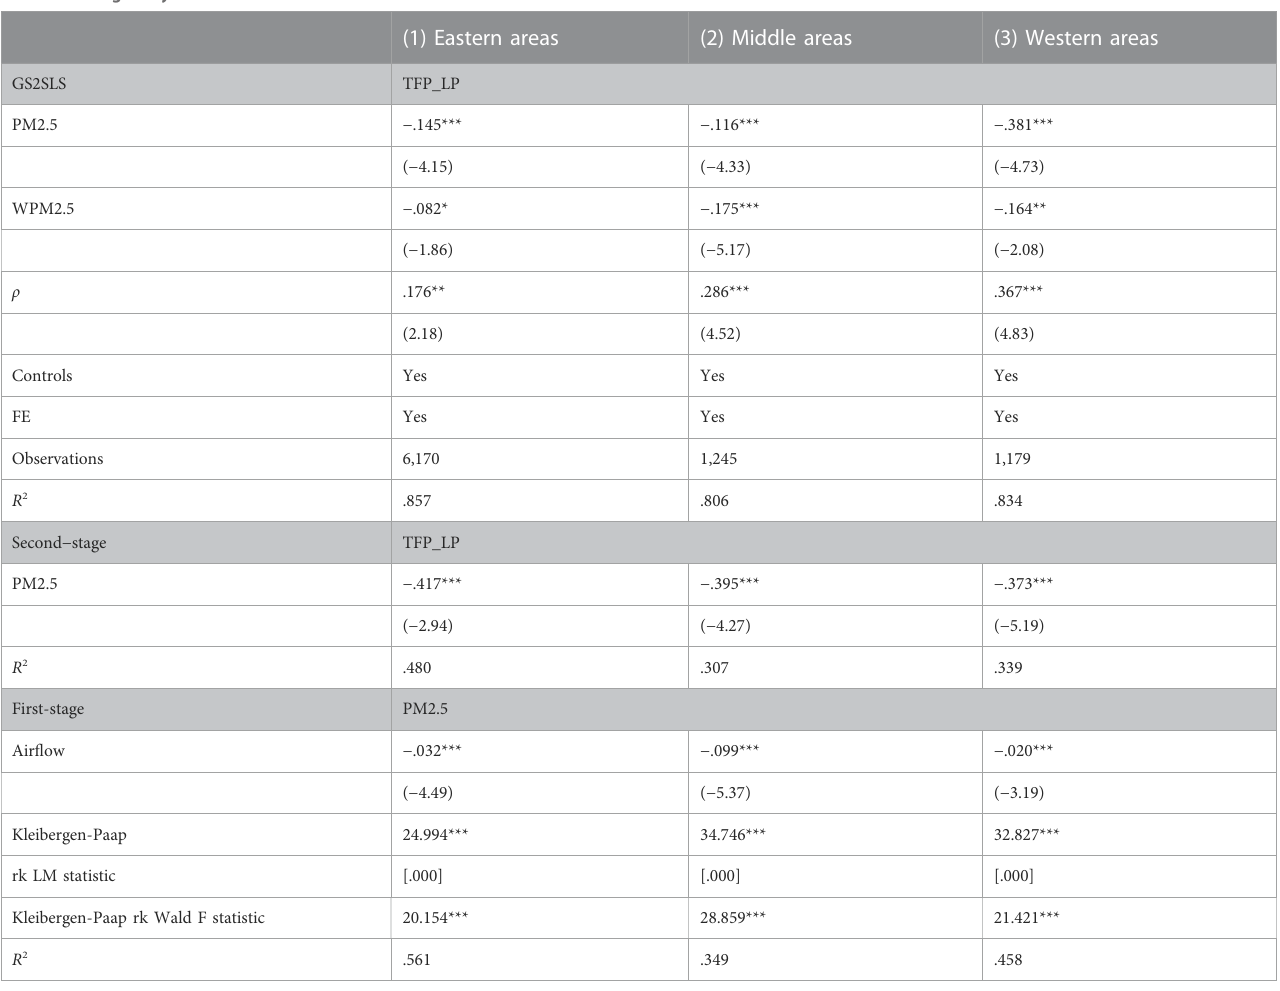
TABLE 7 Endogeneity test with GS2SLS.